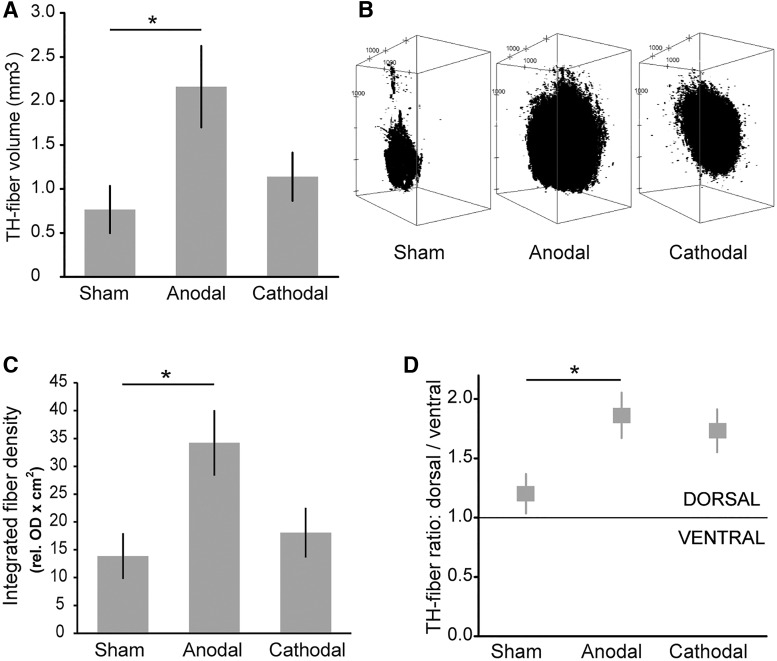
DCS exerted polarity-specific effects on fiber volume, density, and outgrowth direction. A, Anodal DCS significantly enhanced the TH-ir fiber volume surrounding the graft. B, Representative 3D reconstruction of TH-fiber volume in the three groups. Properties of binarized images stacks of individual fiber volumes were adapted to the original slice thickness (40 µm) and spacing between consecutive slices (120 µm). ImageJ plugin 3D viewer was used to render a 3D model of the stack. Stacks are rotated around the y-axis at an angle of 30°, i.e., volumes are shown from a diagonal perspective. Distance between axes tick marks is set to 1000 µm. Note that the fiber volume is largest in the anodal DCS condition. C, Integrated fiber density, the relative OD of TH-ir fibers multiplied by the reinnervated area, was significantly higher in the anodal DCS group compared to sham DCS. D, Both active stimulation paradigms resulted in a larger amount of TH-ir fiber outgrowth directed toward the cranial electrode (dorsal), with only anodal DCS reaching the level of significance. Mean ± SEM; two-tailed Student’s t test each active stimulation versus sham; *p < 0.05.